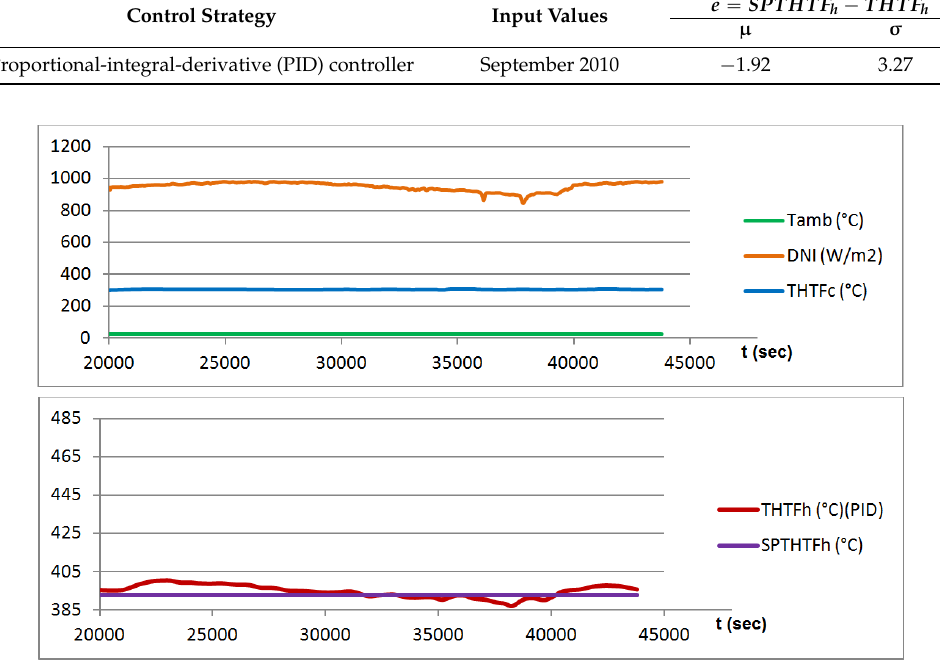
Figure 19. PID controller response to September 2010 values.